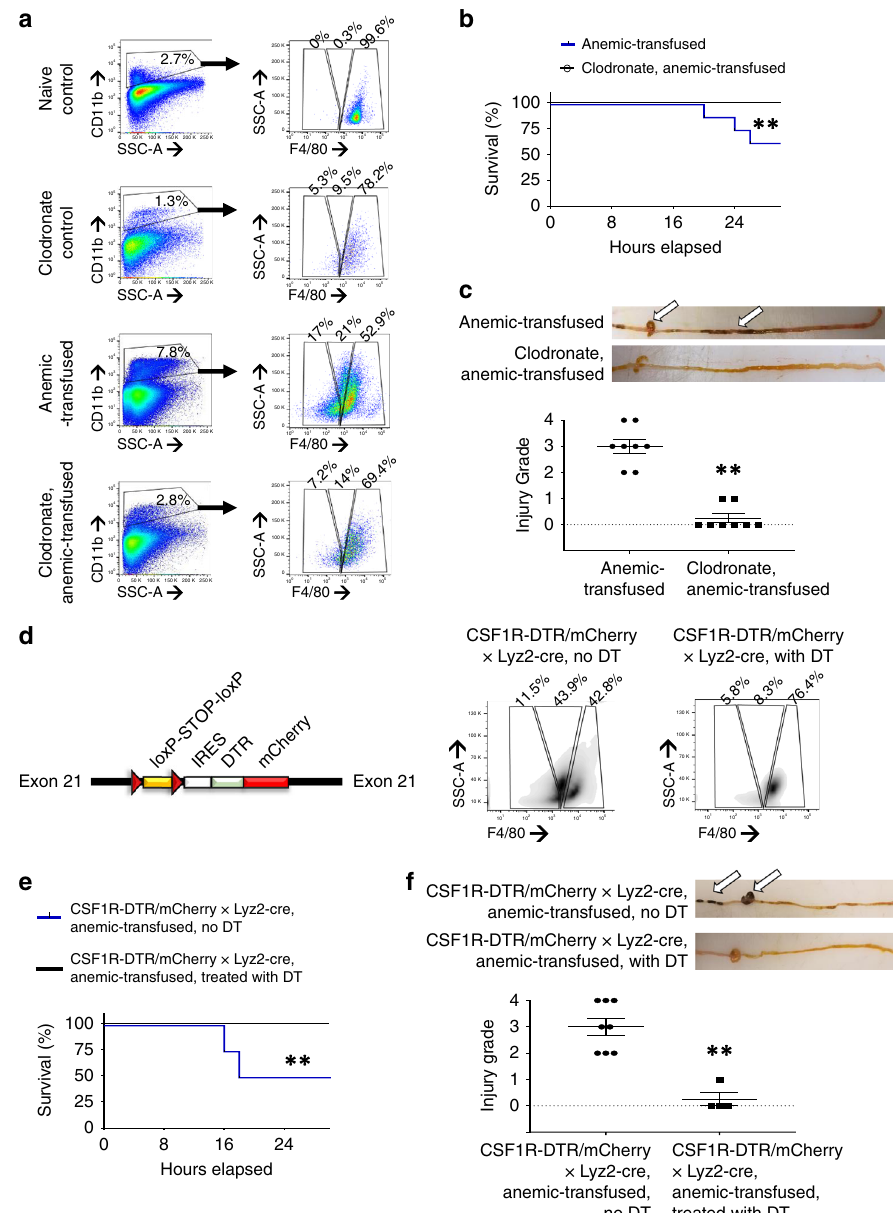
Fig. 7 Macrophages are required for red blood cell (RBC) transfusion-associated necrotizing enterocolitis (NEC). a Representative scatter plots from naive control, anemic-transfused, and corresponding clodronate-treated groups show depletion of F4/80 (hi) macrophages in clodronate-treated naive control, and of both F4/80 (hi) and F4/80 (mid) populations in clodronate-treated anemic-transfused mice. N = 8 mice per group. b Kaplan – Meier curves show survival without intestinal injury in anemic-transfused vs. clodronate-treated anemic-transfused pups; N = 8 mice per group, Mantel – Cox log-rank test, ** P < 0.01. c Top: Representative photographs show intestinal injury in an anemic-transfused pup (arrows) and the absence of injury in a clodronate-treated anemic-transfused pup; bottom: d Scatter plots show severity of bowel injury in anemic-transfused vs. clodronate-treated anemic-transfused mice. N = 8 mice per group; 2 mice in the clodronate-treated group died within 1 h of presumed procedure-related causes and were excluded; Mann – Whitney U test, * P < 0.05. d Schematic (left) of the bacterial arti fi cial chromosome (BAC) encoding a diphtheria toxin receptor (DTR)-mCherry fusion protein preceded by a loxP- fl anked transcriptional Stop element, driven by the CD115 promoter in C57BL/6-Tg(Csf1r-HBEGF/mCherry)1Mnz/J mice; IRES = internal ribosome entry site. Right: representative scatter plots from anemic CSF1R-DTR/mCherry × Lyz2 (lysozyme 2)-cre mice show depletion of F4/80 (mid) CD115 ( + ) Ly6C hi macrophages following DT administration. e Kaplan – Meier curves below show survival without intestinal injury of mock- and DT-treated anemic- transfused mice; N = 6 mock-treated, 4 DT-treated anemic-transfused mice, Mantel – Cox log-rank test, ** P < 0.01. f Top: Representative photographs show intestinal injury in anemic-transfused (arrows) vs. the absence of injury in a DT-treated, anemic-transfused pup. Bottom: Scatter plots show severity of bowel injury in the mock- vs. DT-treated anemic-transfused CSF1R-DTR/mCherry × Lyz2-cre mice. N = 6 mock-treated, 4 DT-treated anemic-transfused mice; Mann – Whitney U test, ** P < 0.01. All scatter plots summarize the data as means ± standard error of the mean